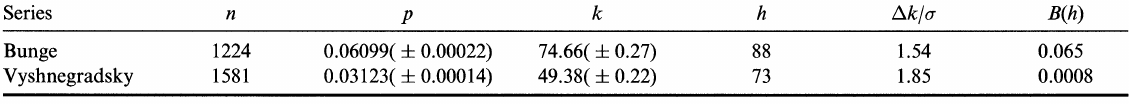
FIGURE 14 Compass rose in absolute values, Vyshnegradsky period. TABLE V Bernoulli hypothesis tests for ruble data, 0#r